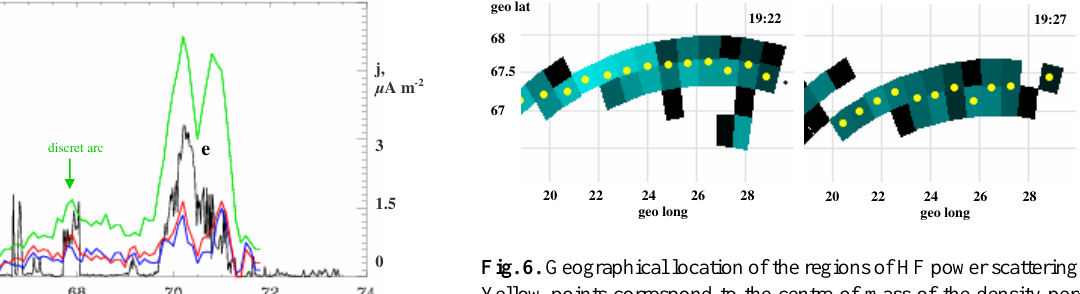
Yellow points correspond to the centre of mass of the density per- Fig. 6